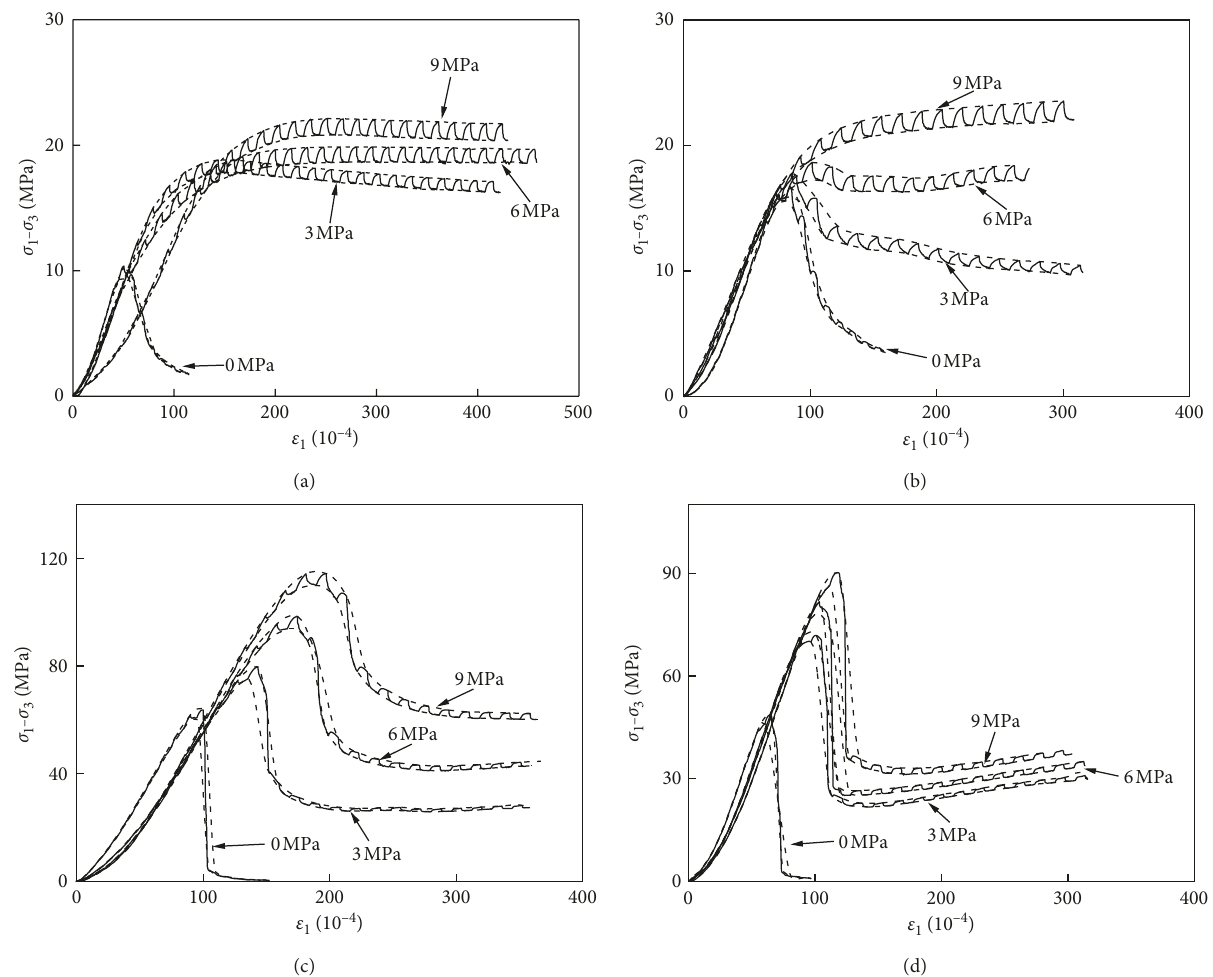
Figure 4: ASR stress-strain curves of wet rocks: (a) Tage tuff, (b) Ogino tuff, (c) Emochi andesite, (d) Jingkou sandstone.